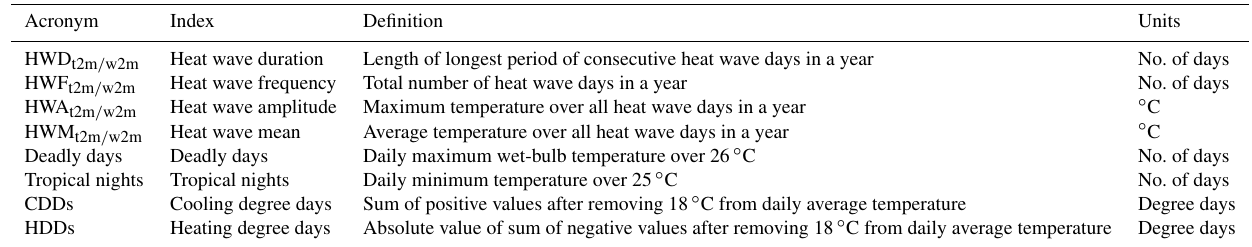
Table 1. Explanation of heat wave indices used in this